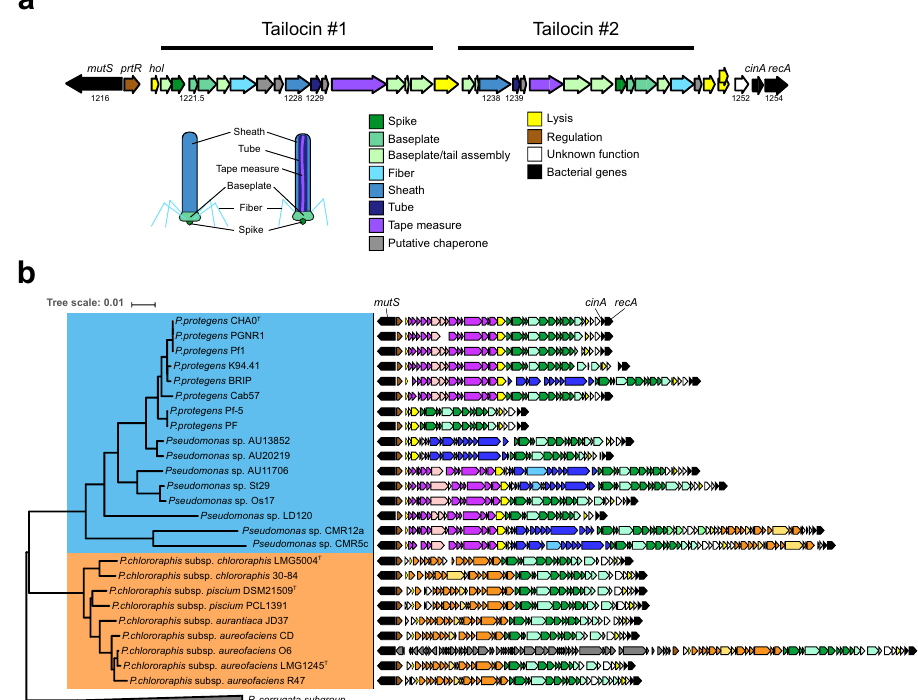
Fig. 3 Architecture of the R-tailocin gene cluster of Pseudomonas protegens CHA0 and diversity of tailocin clusters among strains of the Pseudomonas protegens (Pp) subgroup and Pseudomonas chlororaphis (Pc) subgroup. a The R-tailocin gene cluster of P. protegens CHA0 is composed out of 36 phage- related genes that encode two distinct R-tailocin complexes (tailocin #1, tailocin #2). A detailed description is given in the Supplementary Table 4. b The tailocin loci are situated between the bacterial genes mutS and cinA / recA (black arrows) of Pp (blue) and Pc (orange) strains. Groups of homologous genes are indicated using the same color. The identity levels between these latter are identi fi ed using different color intensities: dark colors describe sequences sharing more than 70% of nucleotide identity on at least 70% of the total gene length while light colors represent sequences sharing less than 70% of identity on at least 70% of the total gene length. Four distinct types of tailocin gene clusters were identi fi ed: purple, green and orange colored tailocin clusters were identi fi ed as encoding R-tailocins while the blue colored cluster encodes an F-tailocin. One entire prophage (gray color) was detected in the tailocin locus of Pseudomonas chlororaphis subsp. aureofaciens O6. Genes encoding the regulator PrtR (brown), lysis-related proteins (yellow) and hypothetical proteins (white) are